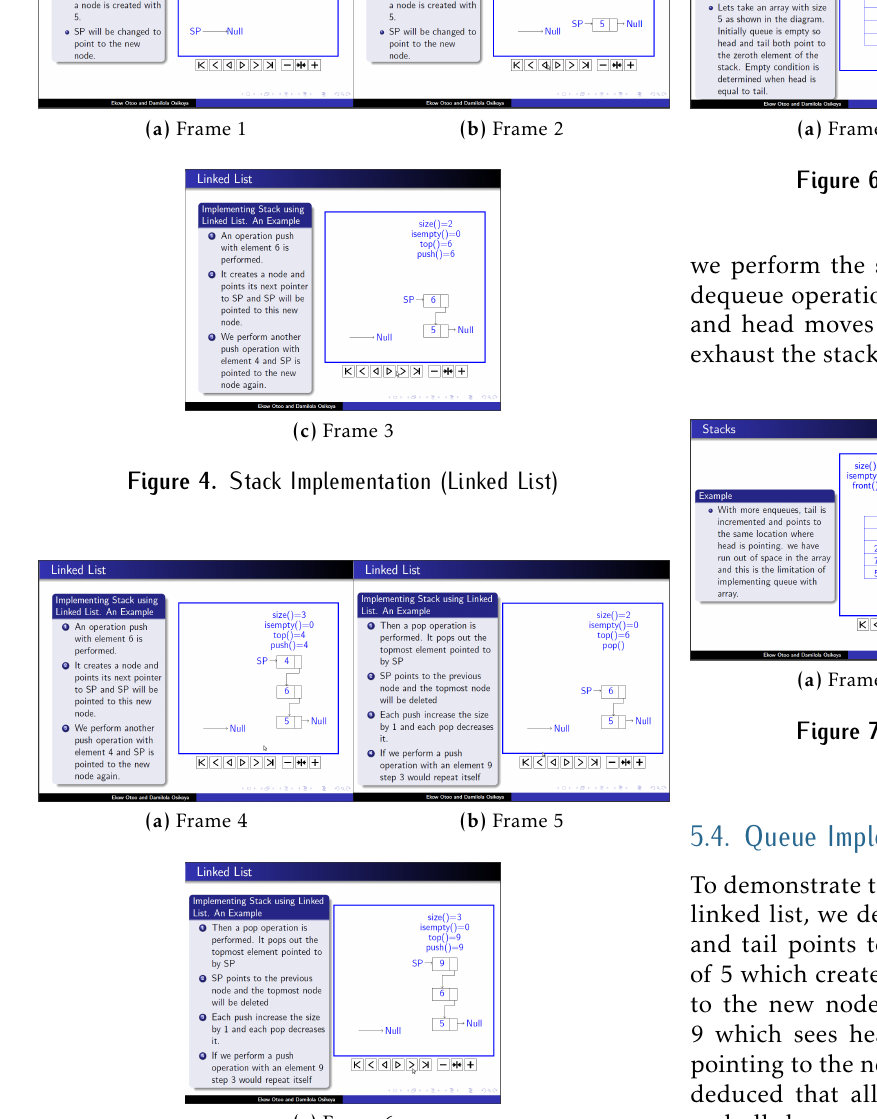
an element in the queue at the tail of a queue and Dequeue() which deletes an element from the the front of the queue. Other operations include Size(), IsEmpty(), top() and front().